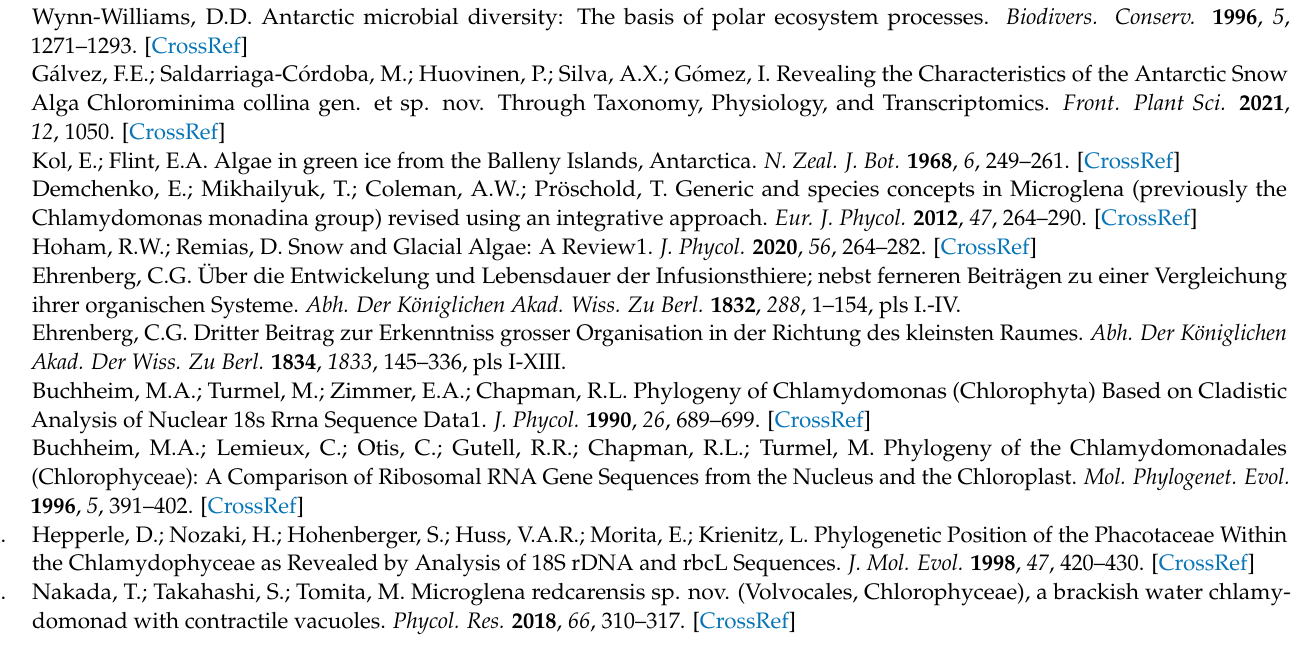
Figure S2. ITS-2 ML tree. Approximate Likelihood Ratio Tests based on Shimodaira-Hasegawa-like procedures (SH-aLRT) values (%), Bayesian Posterior Probabilities (PP) and ML bootstrap values (%) are shown above